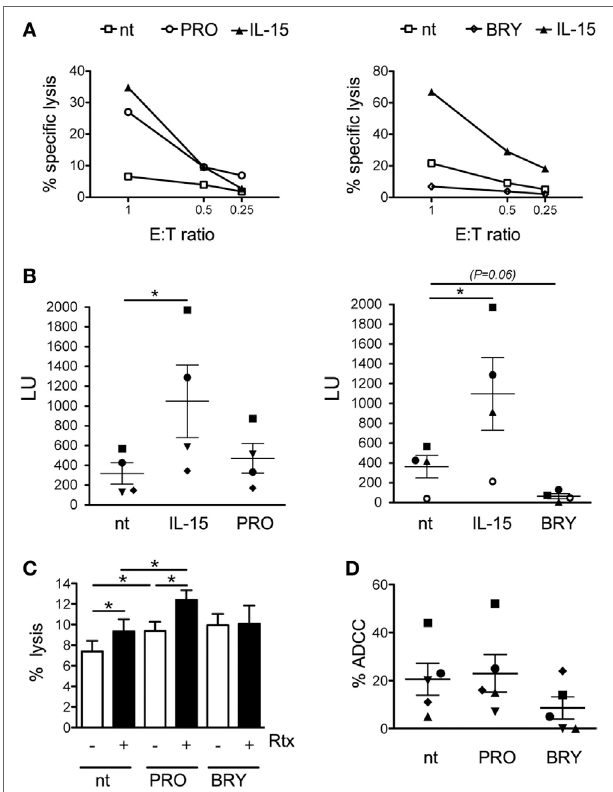
FigUre 3 | Impact of prostratin (PRO) and bryostatin-1 (BRY) on natural killer (NK)-cell cytotoxicity. (a) NK cells cultivated for 18 h without stimuli [not treated (nt)], with 12.5 ng/ml of IL-15, 10 µM PRO or 5 nM BRY were tested for cytotoxicity against K562 cell targets at the indicated E:T ratio. The percent specific lysis of two representative experiments is shown. (B) The NK cell-mediated lysis measured in four independent experiments like the one shown in panel (a) was converted in lytic units (LU, mean ± SEM). Each symbol represents one donor. (c,D) NK cells treated for 18 h with 1 µM PRO or 10 nM BRY or nt were tested against Raji cells coated or not with rituximab (Rtx) monoclonal antibody. The efficiency of overall lysis (c) and antibody-dependent cellular cytotoxicity (D) were measured in five donors. The mean ± SEM is reported. * P < 0.05 by paired t